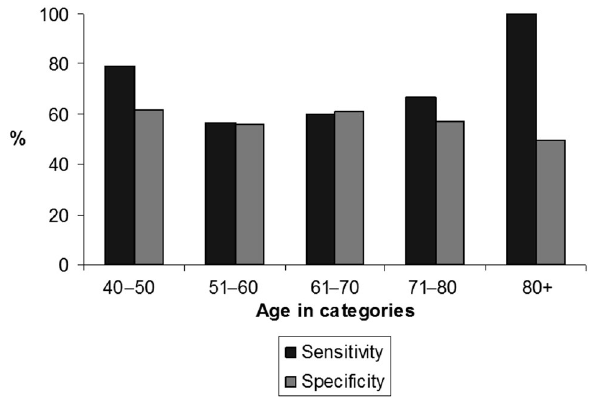
Fig. 4 Age-speci fi c sensitivity and speci fi city of the SCSQ (cut-off point >= 2) to predict PBD FEV 1 /FVC < LLN in the primary care